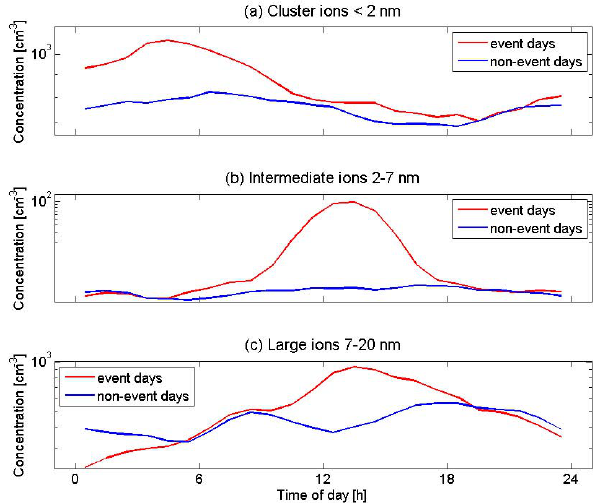
Fig. 6. Median diurnal cycles for different ion sizes, separated by days with and without new particle formation (event/non-event days). (a) Cluster ions <2nm. (b) Intermediate ions 2–7nm. (c) Large ions 7–20nm. Concentrations refer to the sum of positive and negative